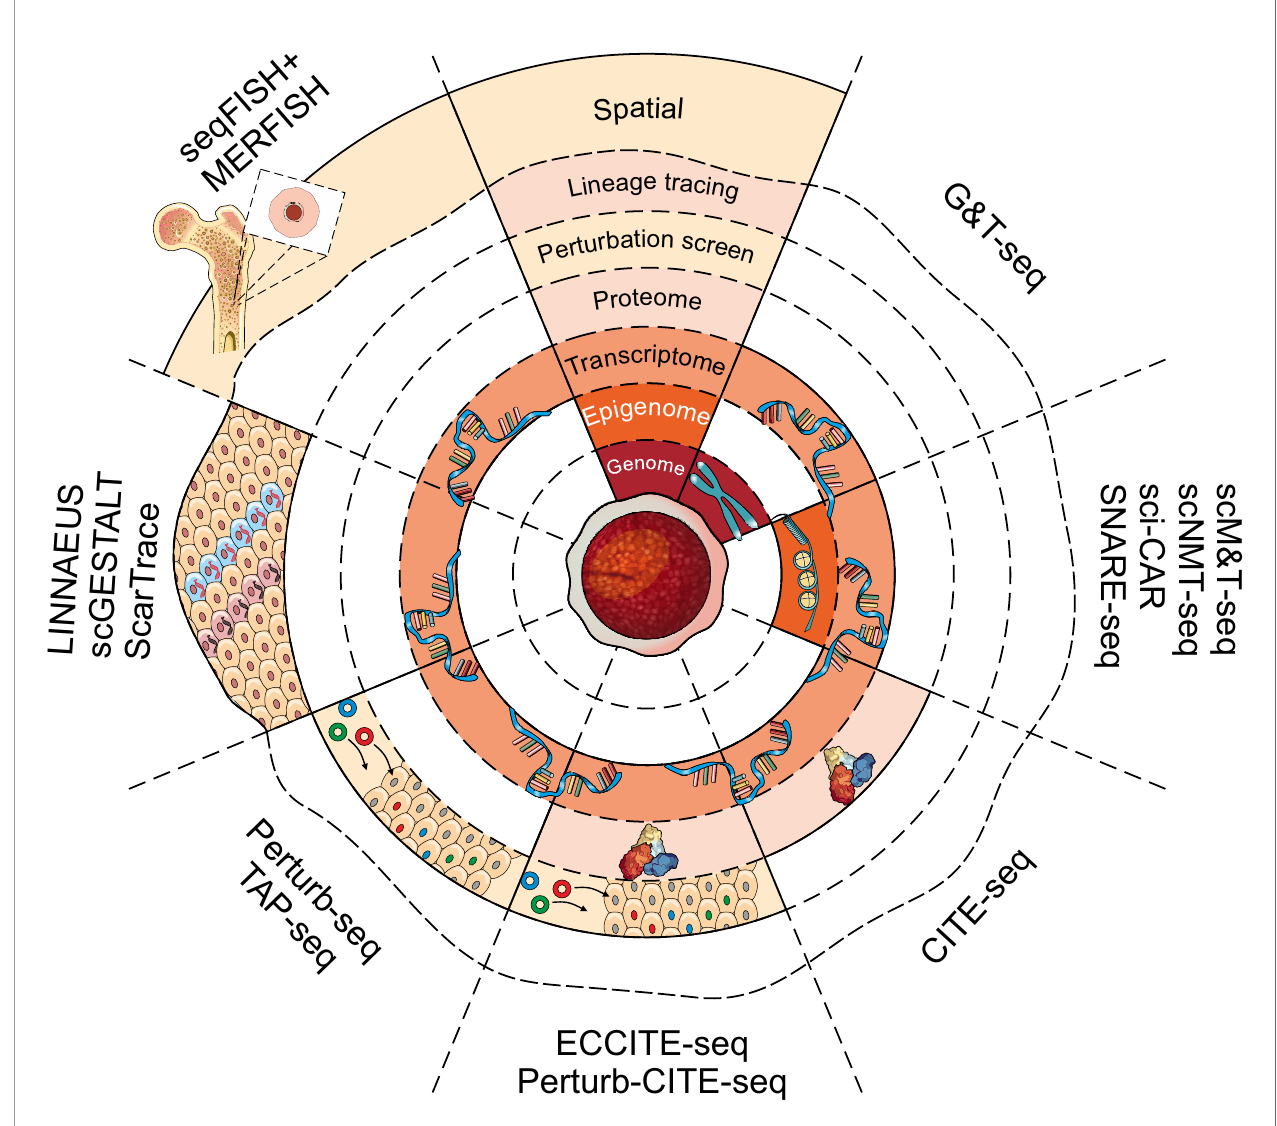
FIGURE 3 | Single-cell multimodal platforms and their uses. A number of recently developed technologies can be used to assess the genomic, transcriptomic, epigenomic and proteomic landscape of a single cell. Each layer of the concentric circle represents a different molecular dimension that can be assessed using each method (from inside to outside: genome, epigenome, transcriptome, proteome, genetic perturbation, lineage tracing, spatial transcriptome). Method names are indicated along the